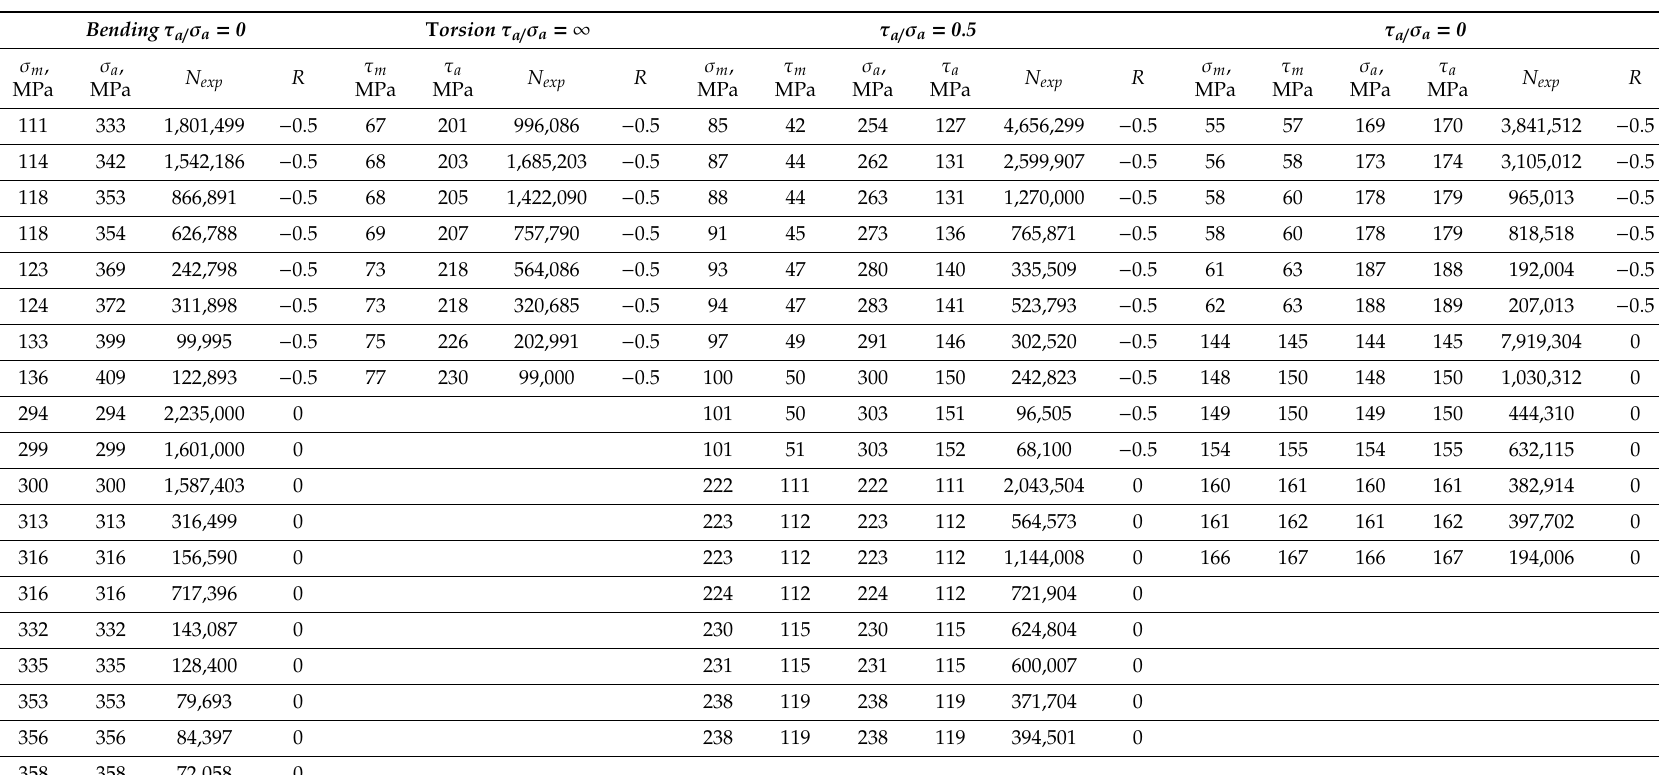
Table A2. Experimental results for the S355 steel obtained under cyclic bending, torsion, and combined bending–torsion with di ff erent stress ratios. Bending τ a / σ a =